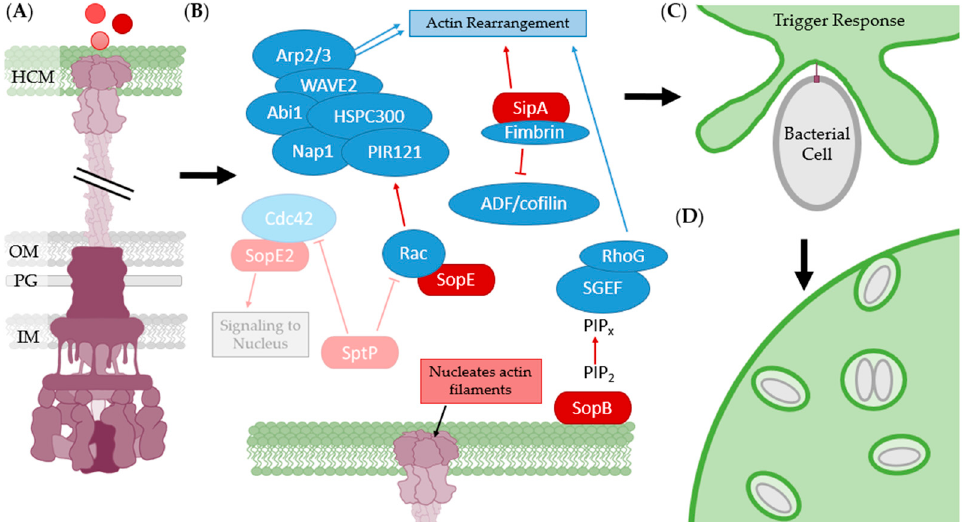
Figure 20. Process of T3SS-1-related trigger internalization in S. enterica . ( A ) Pathogen contacts the host cell via T3SS-1 and secretes effectors, including SipA, SopE, SopE2, SopB, and SptP; ( B ) These effectors (red) interact with numerous host factors (blue) that lead to actin rearrangement and polymerization. SipC acts as a nucleus for actin filaments, with growth outwards from the pore; ( C ) Actin rearrangement causes the formation of membrane ruffling that then engulfs the bacterial cell; ( D ) Once within the SCV, it expresses T3SS-2 and begins proliferation. Multiple bacterial cells can be internalized within a single host cell. Modified from [238]. Abbreviations: OM, outer membrane; PG, peptidoglycan; IM, inner membrane; HCM, host cell membrane.